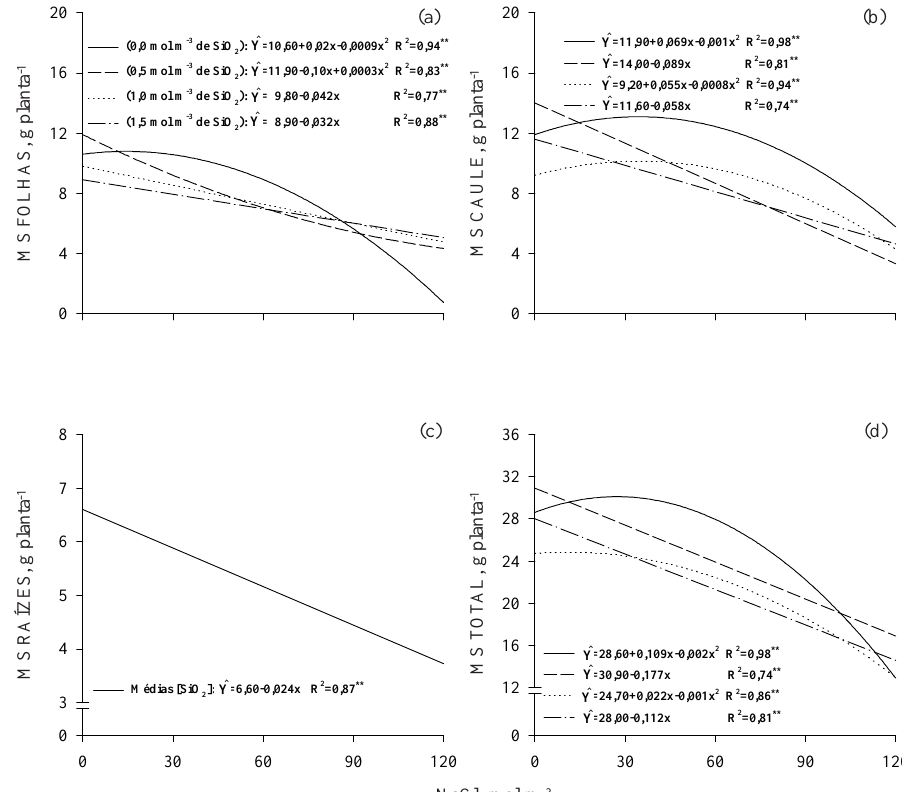
Figura 5. Acúmulo de matéria seca pelas folhas (a), caule (b), raízes (c) e acúmulo total (d), considerando a concentração de NaCl e SiO 2